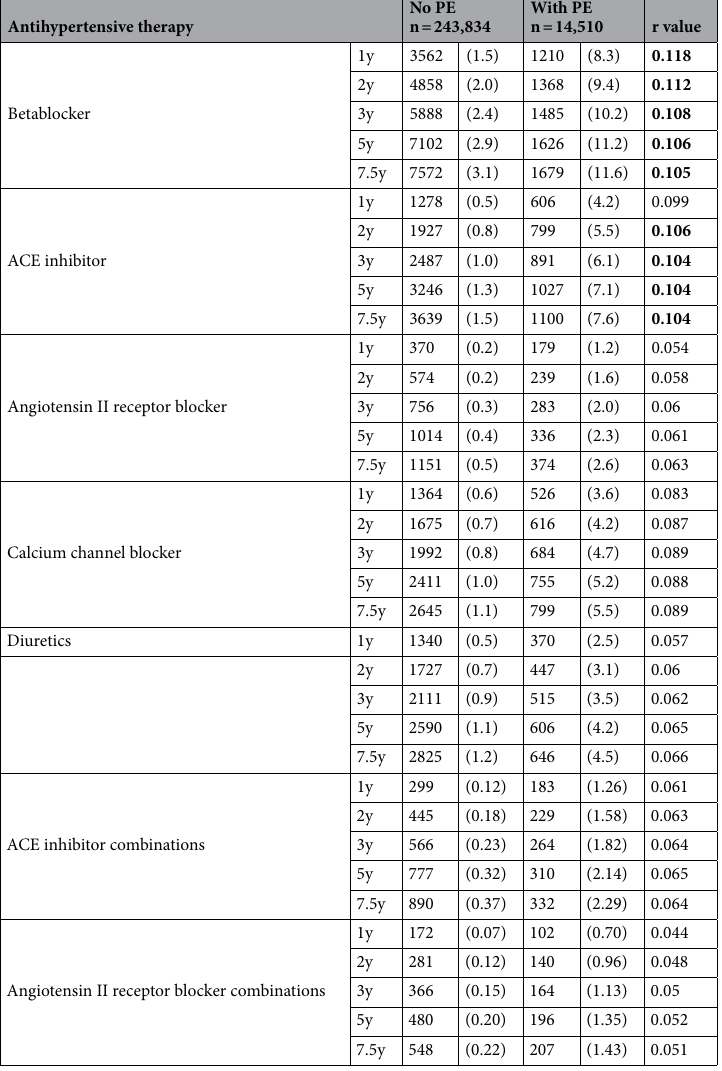
Table 2. Number of patients receiving antihypertensive therapy during follow-up stratified for the occurrence of PE. Data are presented as absolute numbers (cumulative percentages) and were compared using χ 2 test with Yates’ continuity correction. Bold values indicate r values > 0.1. P values not shown, as for each row p < 0.0001. PE: preeclampsia; ACE: angiotensin-converting